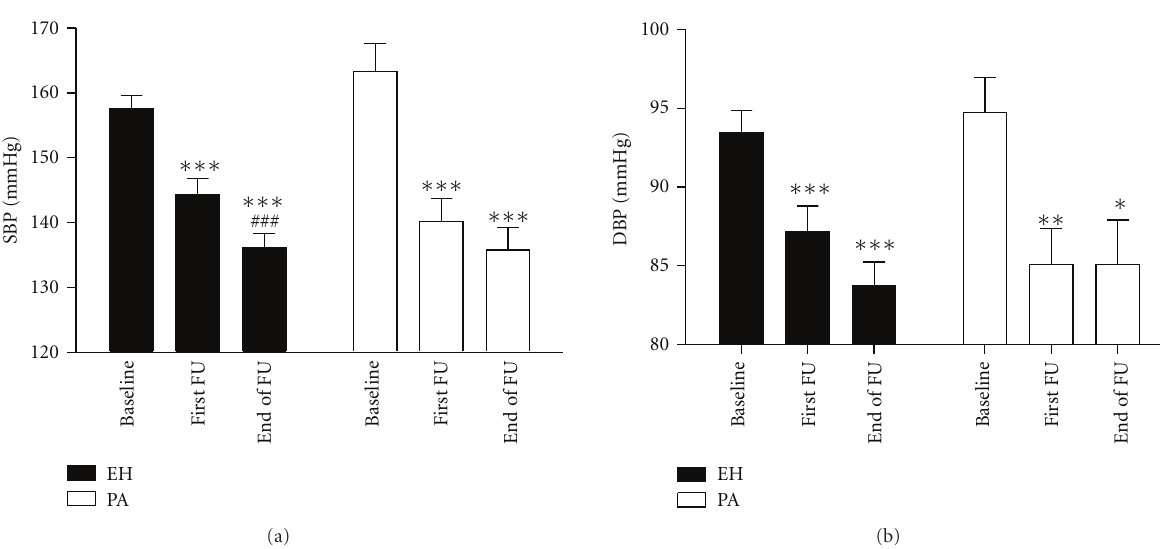
Figure 1: Systolic (SBP) and diastolic (DBP) blood pressure before start with an aldosterone-receptor antagonist (baseline), at first followup (FU), and at the end of FU in patients with essential hypertension (EH) and primary aldosteronism (PA). Overall trend was tested with one-way ANOVA for repeated measurements ( P < . 001 for all groups, except for DBP in the PA group ( P = . 001)). Indicated significance levels are for di ff erences between groups after adjustment for multiple comparisons ( ∗ compared to baseline; # compared to first FU).